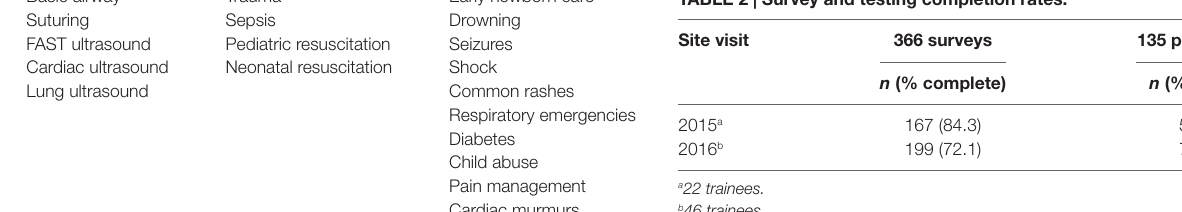
taBle 2 | survey and testing completion rates.